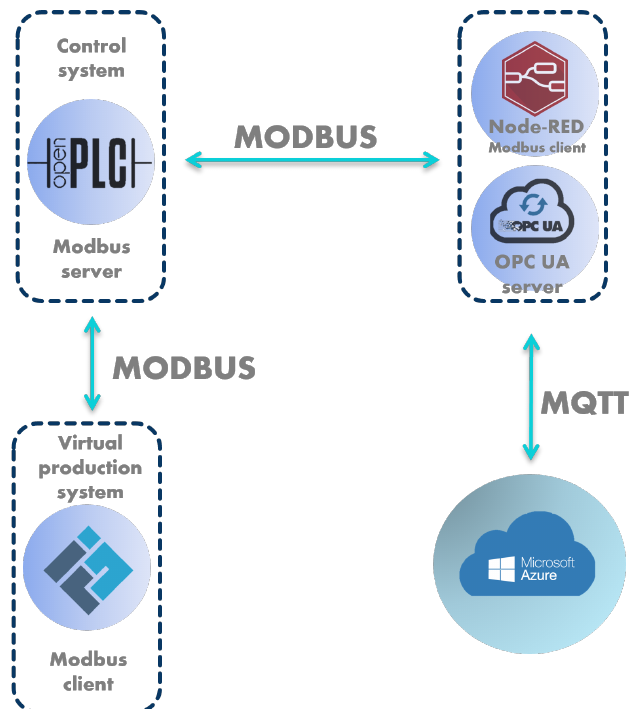
Figure 2. OpenPLC linked with Node-RED and Microsoft